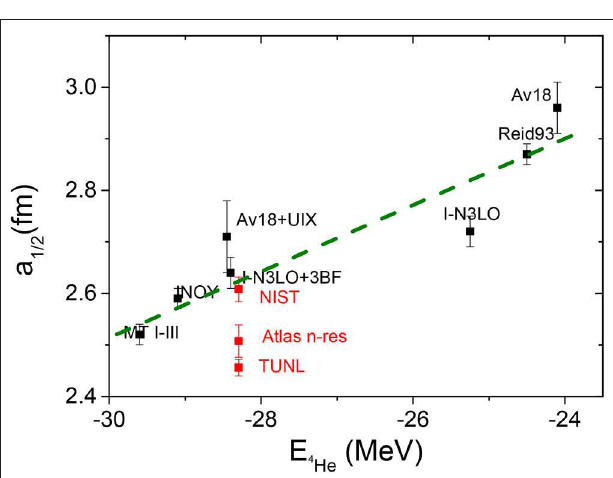
FIGURE 10 | Apparent correlation between the calculated 4 He binding energies and n- 4 He scattering length. Calculated values are compared with those adapted from the experiment by NIST [ 100], Atlas n-res [99], and TUNL